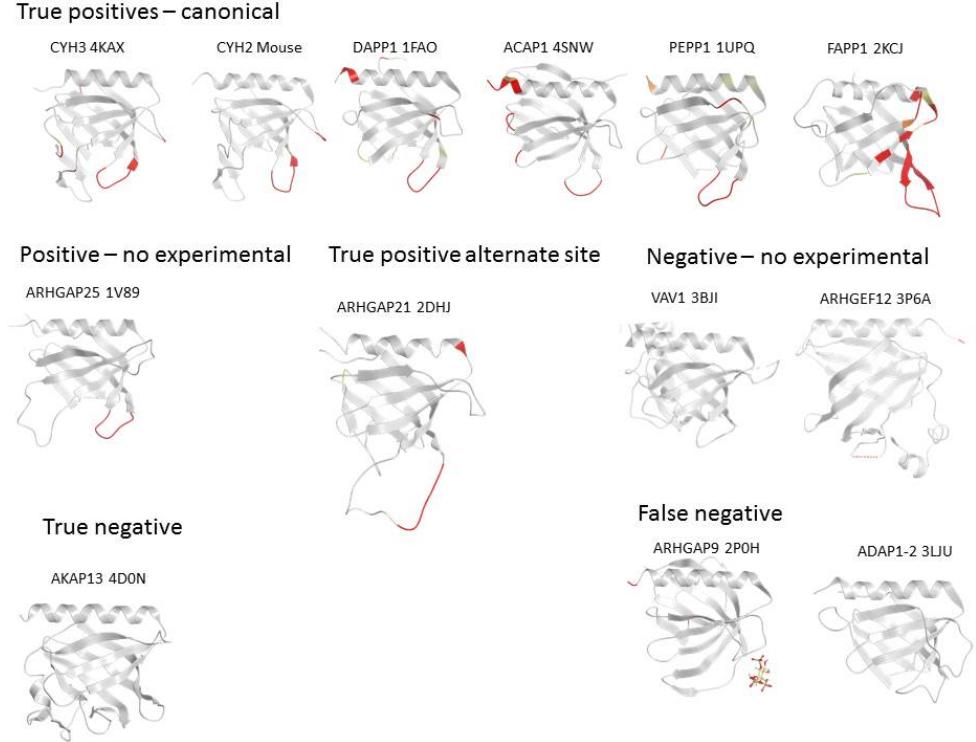
Figure 3. Examples of PH domain structures showing the membrane interaction sites that are predicted by MODA. The name of each protein is followed by the PDB deposition number and is indicated above each structure. The predicted membrane interacting sites are shown in a gradient of red-orange-yellow [11] and missing segments are represented by dotted